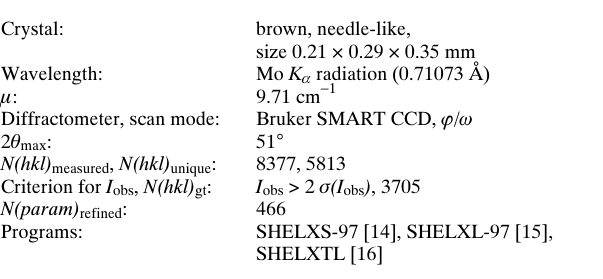
Table 1. Data collection and